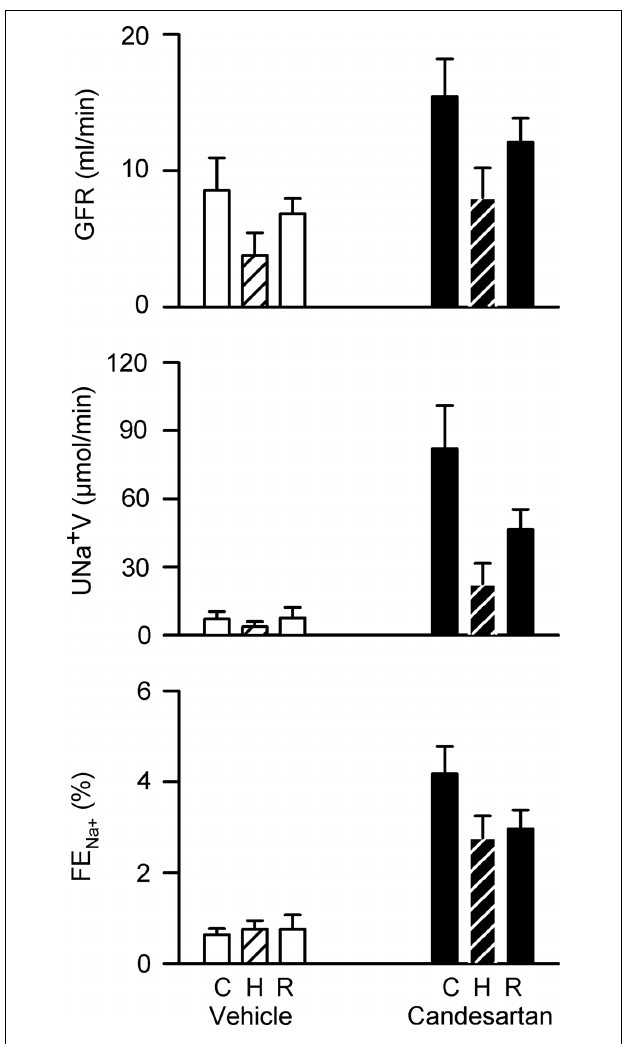
FIGURE 3 | Responses of renal excretory variables to hypoxia in conscious rabbits treated with candesartan or its vehicle. GFR, glomerular filtration rate, U Na + V, sodium excretion; FE Na + , fractional sodium excretion; C, control; H, hypoxia; R, recovery. P values for the outcomes of two-way repeated measures analysis of variance are shown in Table 2 . These indicate significant effects of candesartan on U Na + V and FE Na + and a significant effect of hypoxia on GFR. However, candesartan did not significantly affect responses to hypoxia.